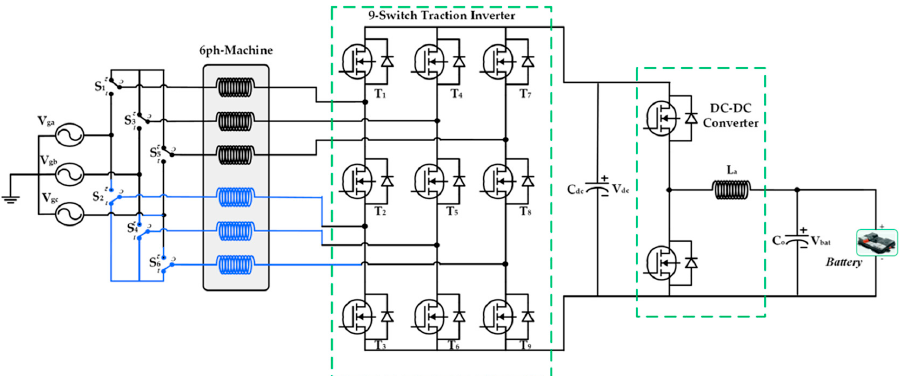
Figure 17. Integrated On − Board Charger based on Nine Phase Six Phase Winding Machine proposed by Diab et al. [87] in 2016. (iOBC13).